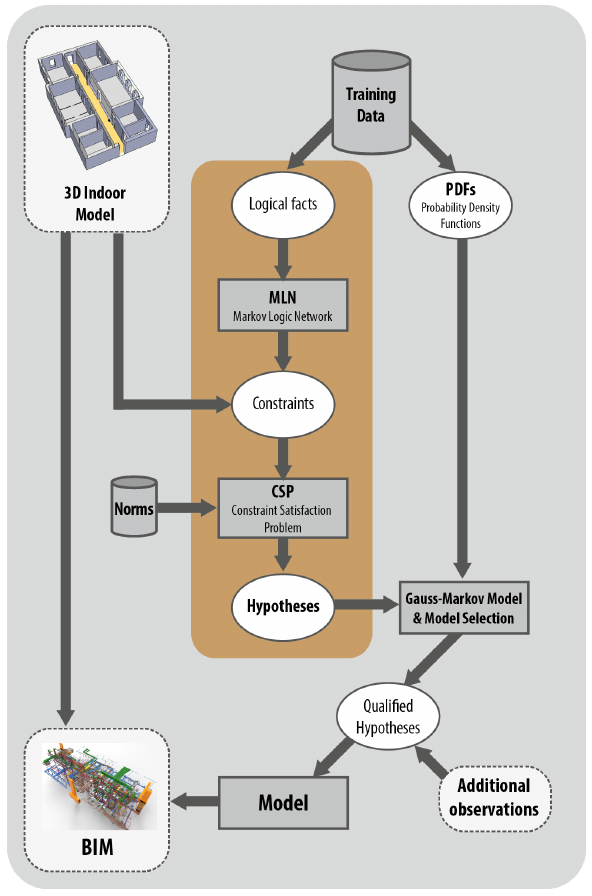
Figure 6: A survey of our concept for expanding 3D building models by electric installations for BIM.